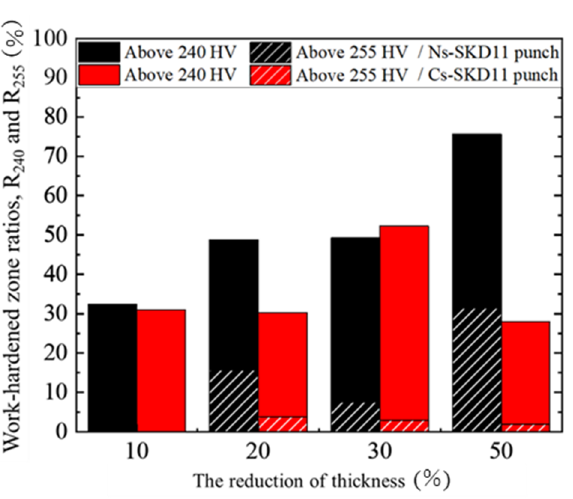
Figure 12. Variation of the work-hardening area in the forged β -titanium alloy wire with an increasing reduction in thickness.